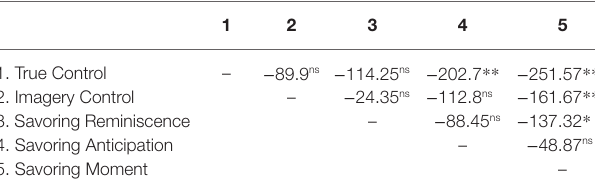
TABLE 3 | Fisher’s least significant differences post -hoc test at time